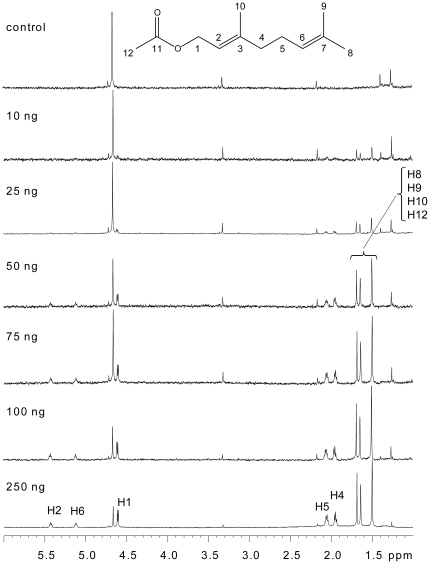
Detection limits of 1H-NMR of geranyl acetate.